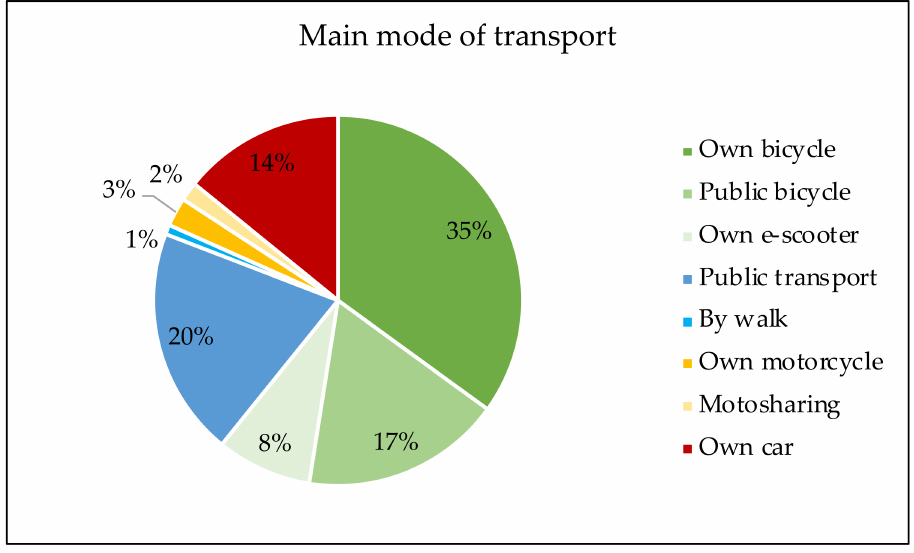
Figure 5. Main mode of transport of the respondents.